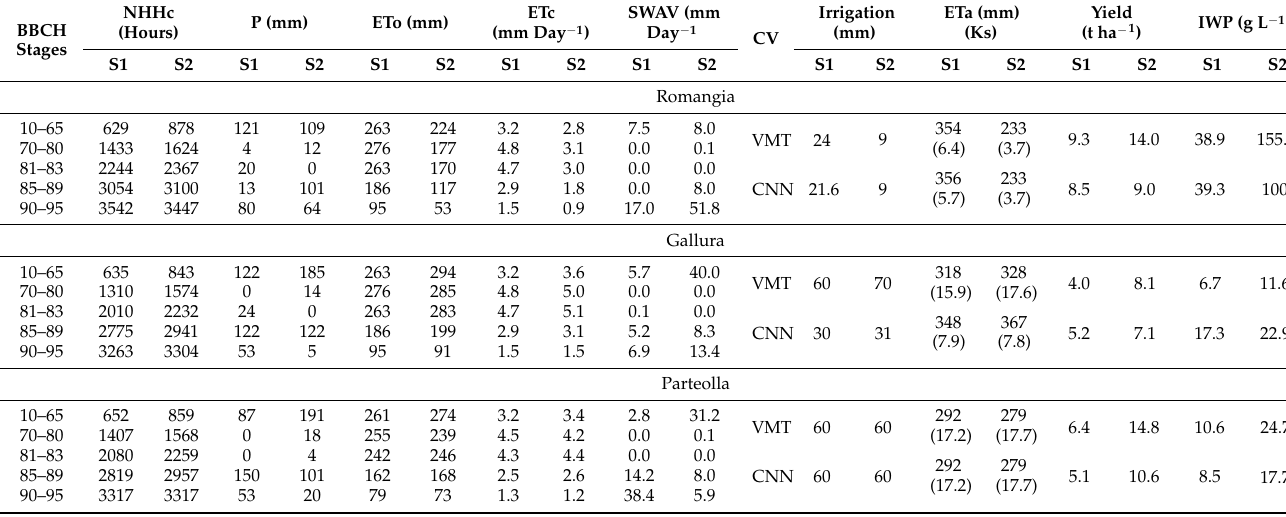
Table 2. Accumulated thermal time at specific phenological stages (from BBCH 10 until BBCH 95), vineyard water balance variables, yield, irrigation volume and irrigation water productivity for the two growing